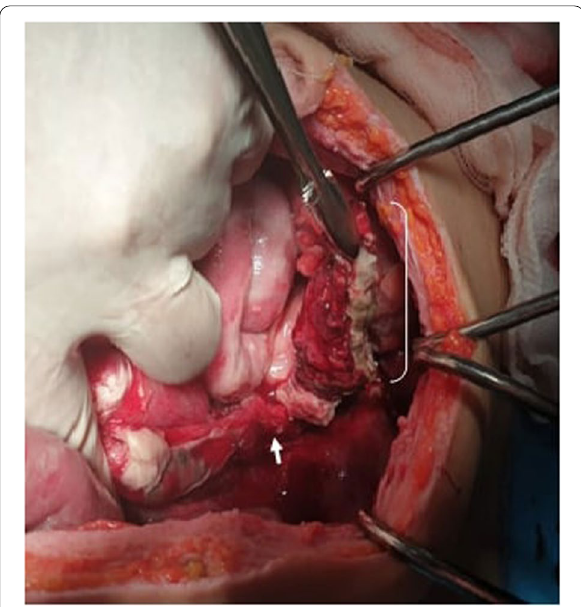
Fig. 2 Per-operative findings. White arrow: appendicular basis. White arch: gangrenous appendix disinserted at its